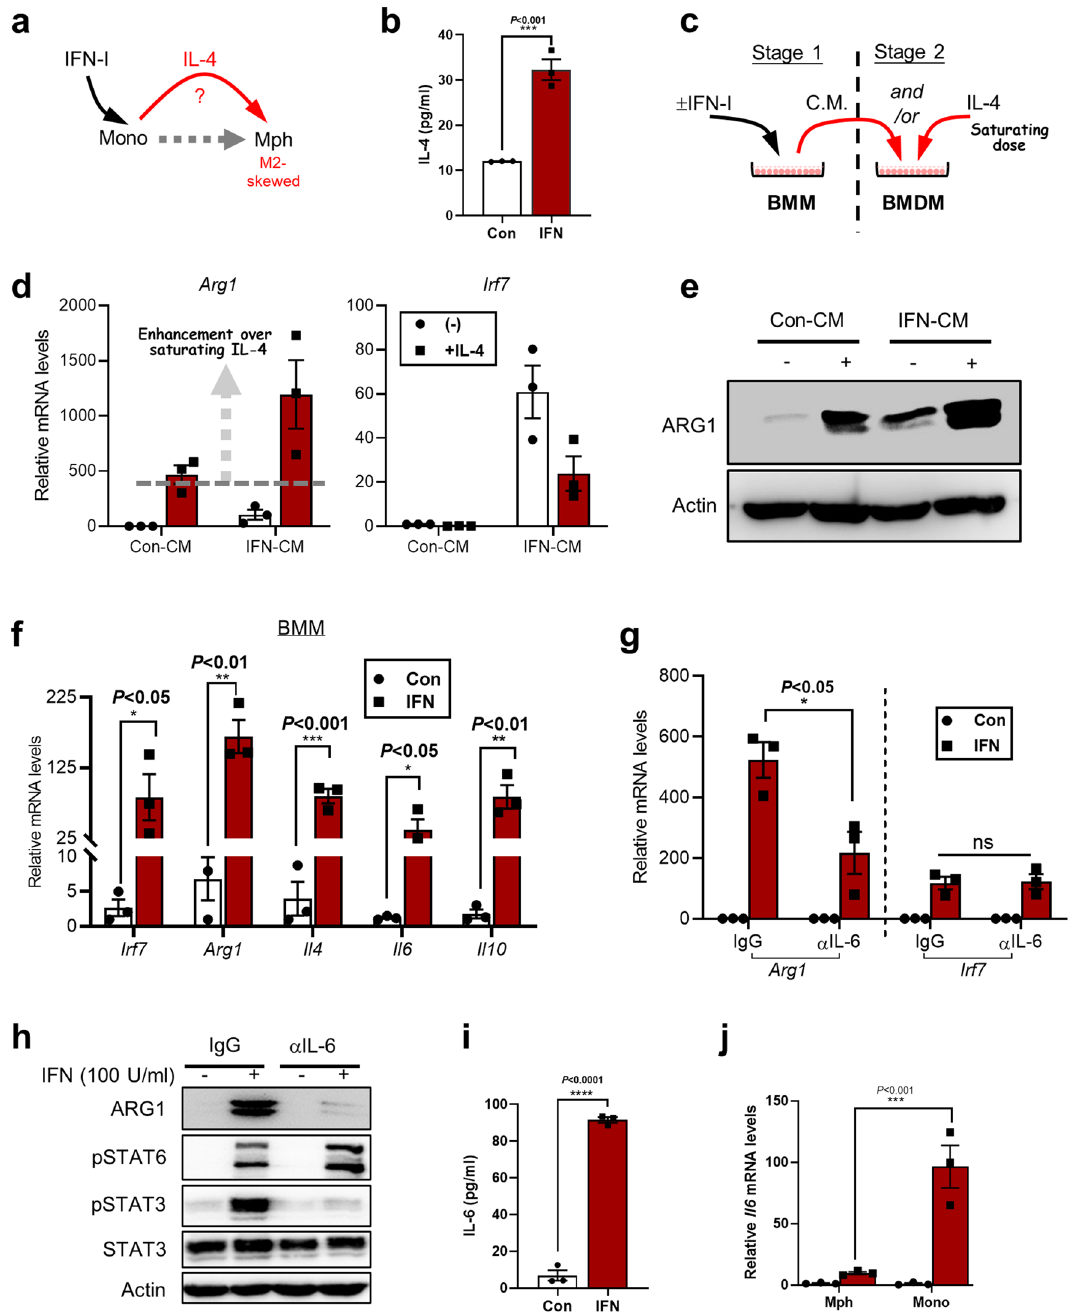
Figure 1. IFN-stimulated transitional monocytes release IL-6 to promote IL-4-mediated induction of ARG1 in macrophages. ( a ) A schematic drawing shows the hypothesis that IFN-treatment of monocytes may release of a yet-to-be determined soluble factor(s) that acts together with previously established IL-4 to drive the M2-skewing of mature macrophages. The differentiation transition from monocytes to macrophages is also denoted by a dotted arrow. ( b ) BM mononuclear cells were treated with IFN (100 U/ml) for 24 h in the presence of M-CSF (20 ng/ml), the production of IL-4 in cell supernatants was determined by ELISA (n = 3, ± SEM). ( c–e ) The experiment scheme is shown in ( c ). In the first stage, BM mononuclear cells (BMM) were treated with M-SCF ± IFN for 48 h. The conditioned media (C.M.) were harvested. In the second stage, the C.M. from control or treated cells were transferred to naïve, mature macrophages (BMDMs). The BMDMs were treated for 48 h with either the C.M. alone or the C.M. and a saturating dose of IL-4. The cells were harvested and subjected to qPCR (n = 3, ± SEM) ( d ) or Western blot (WB) analyses ( e ). ( f ) BM mononuclear cells were treated with M-SCF ± IFN for 48 h, samples were harvested for mRNA analyses of indicated markers and cytokine genes (n = 3, ± SEM). ( g,h ) BM mononuclear cells were treated with M-CSF ± IFNβ for 48 h. In some groups, neutralizing Abs against IL-6 (5 μg/ml) were added to the medium as indicated. Samples were harvested after 48 h for mRNA [n = 3, ± SEM] ( g ) or protein ( h ) analyses. ( i ) BM mononuclear cells were treated with IFN for 24 h in the presence of M-CSF, the production of IL-6 in cell supernatants was determined by ELISA (n = 3, ± SEM). ( j ) BM mononuclear cells were treated with M-SCF ± IFN for 48 h, monocytes (Ly6C + F4/80 − ) and macrophages (F4/80 + ) were sorted by flow cytometry. Samples from sorted cells were subjected to qPCR analysis (n = 3, ± SEM). For most statistical analyses related to this figure, unpaired t tests were performed ( P value marked on the graph). For ( j ), 2-way ANOVA tests were performed (the adjusted P value presented). Asterisks correspond to P values (**** P < 0.0001; *** P < 0.001; ** P < 0.01; * P < 0.05; ns not